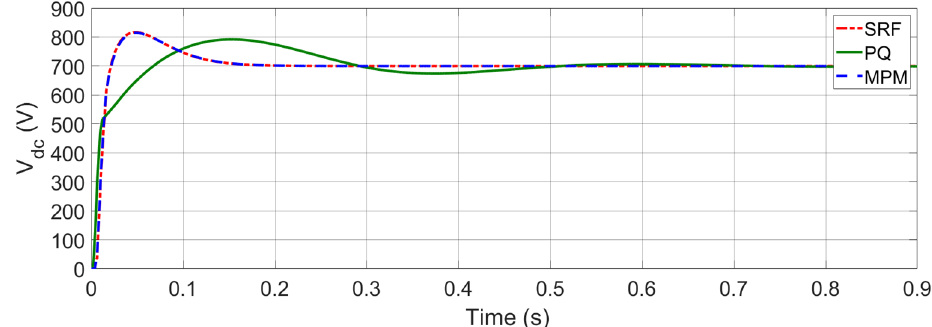
Figure 8. DC-link capacitor’s voltage value PQ, SRF, and